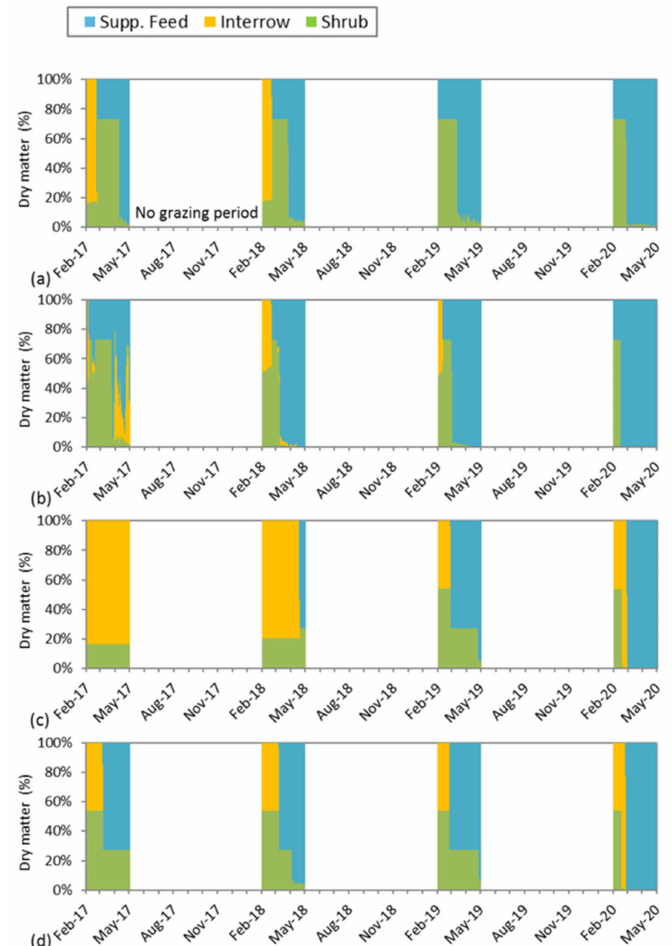
Figure 6. The proportional daily amount of saltbush shrub (green columns), interrow (yellow columns) and supplementary feed (blue columns) in the total diet for ( a ) medic pasture, ( b ) panic pasture, ( c ) unharvested oats, and ( d ) harvested barley for Waitchie with a defined 90-day grazing period February 1 to May 1 each year. Note: These are stacked column graphs with each day of the year shown to indicate the different feed sources during the grazing period and between years. The blank area indicates the 275-day period when there was no